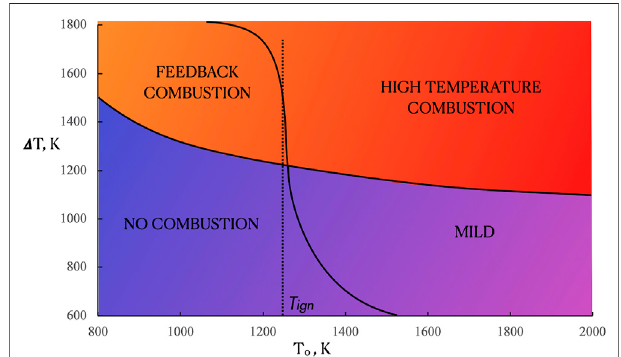
FIGURE8| MapofbehaviorforpureammoniaintheHFDFcon fi guration at P (cid:1) 20 atm.